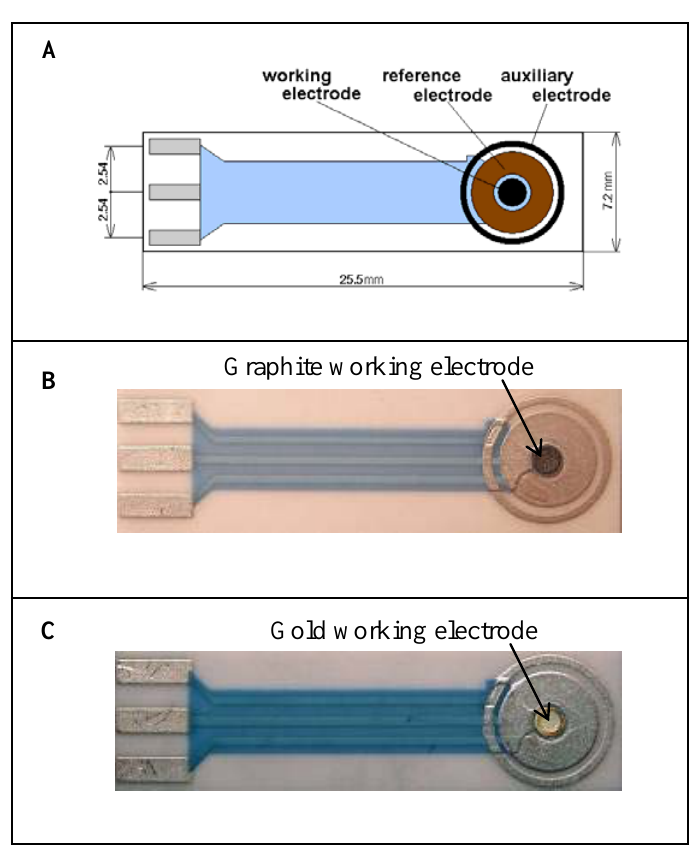
Figure 1. Thick-film technology (TFT) sensor design ( A ) and real TFT sensor with reference (Ag/AgCl) electrode, carbon auxiliary electrode and graphite ( B ) or gold ( C ) working